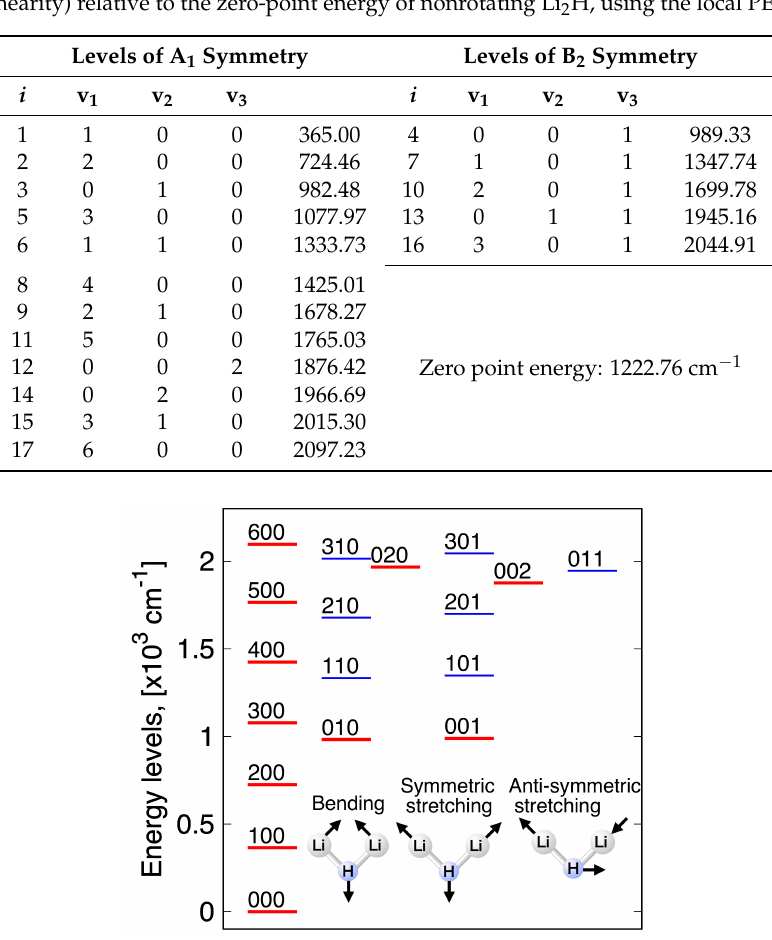
Figure 12. Energy diagram of some low-lying vibrational energy levels (v 1 v 2 v 3 ) of the ground electronic state of the Li 2 H complex. Levels underlined in red (blue) are one-mode (resp. two-mode) energy levels.